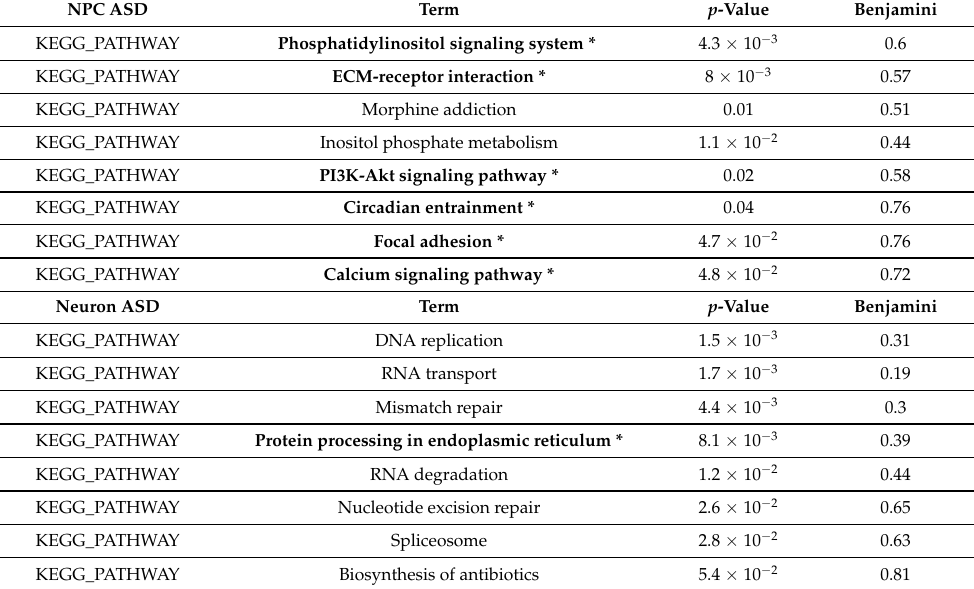
Table 2. The KEGG pathways enriched by the unique target genes in the ASD samples of NPC and neuron